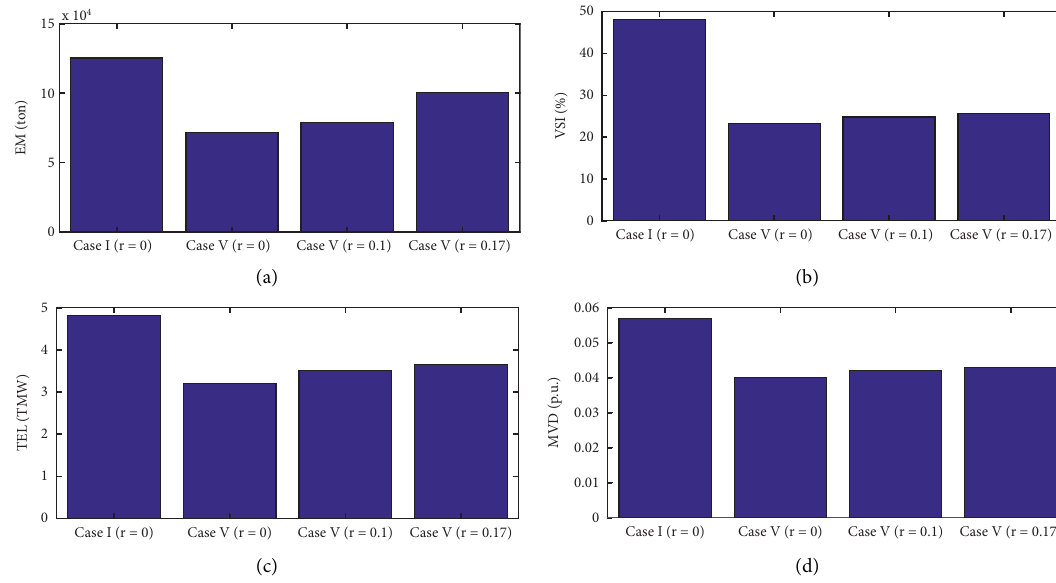
1: (a) EM; (b) VSI; (c) TEL; (d) MVD. (cid:29)